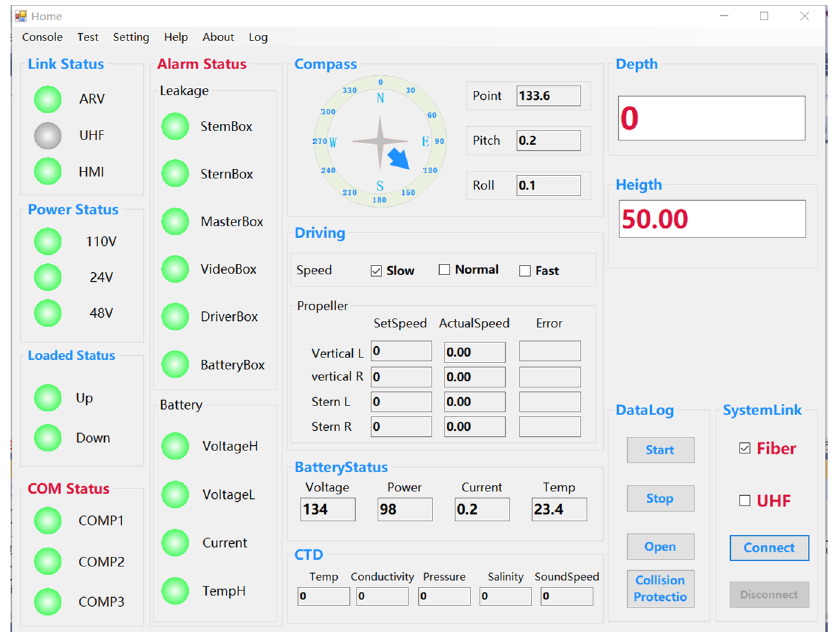
Figure 14. The operation interface of the surface control